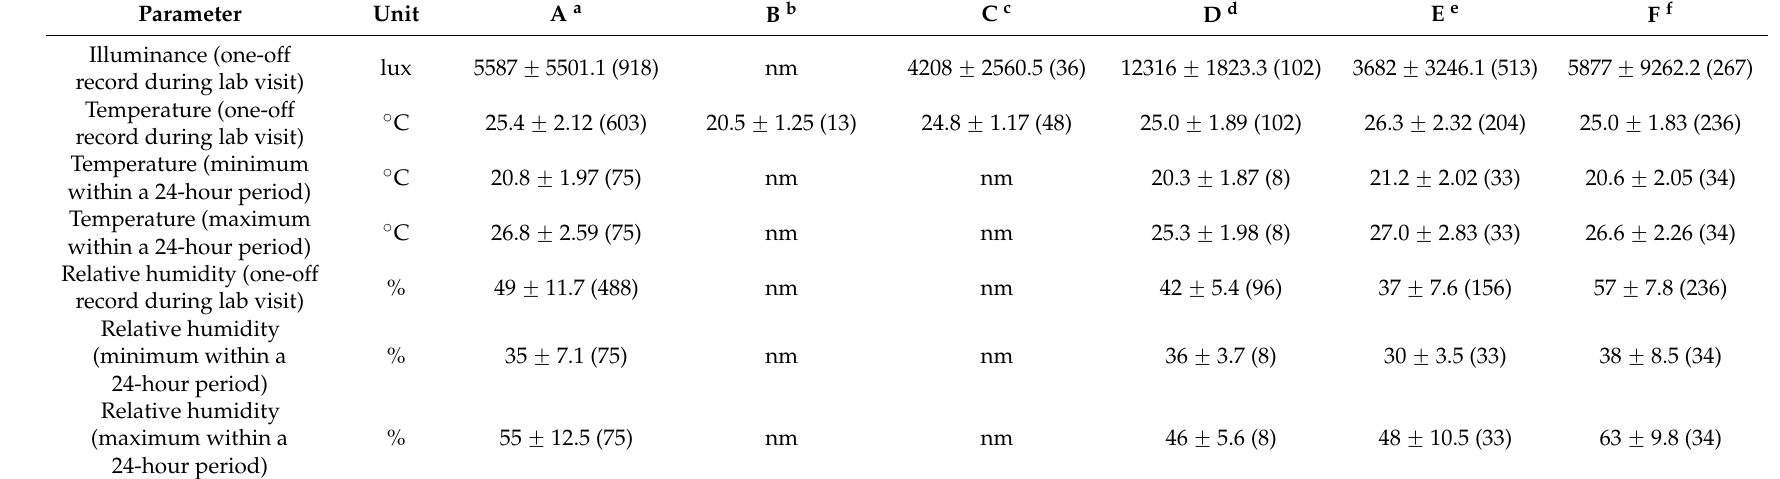
Table 5. Overview of environmental boundary conditions associated with the vegetable pots (mean ˘ standard deviation (number of